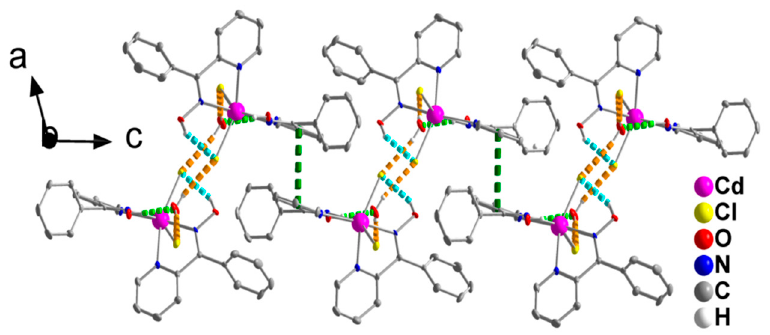
Figure 4. Formation of layers parallel to the (001) plane through π - π stacking interactions (dashed dark green lines) in the crystal structure of 1 · H 2 O (see text for details). The view is presented along the b axis. The color code for the hydrogen bonds is the same as used in Figure 3. Table 4. Selected interatomic distances (Å) and angles (°) for complex {[CdCl 2 (phpaoH)]} n ( 2 ) a .